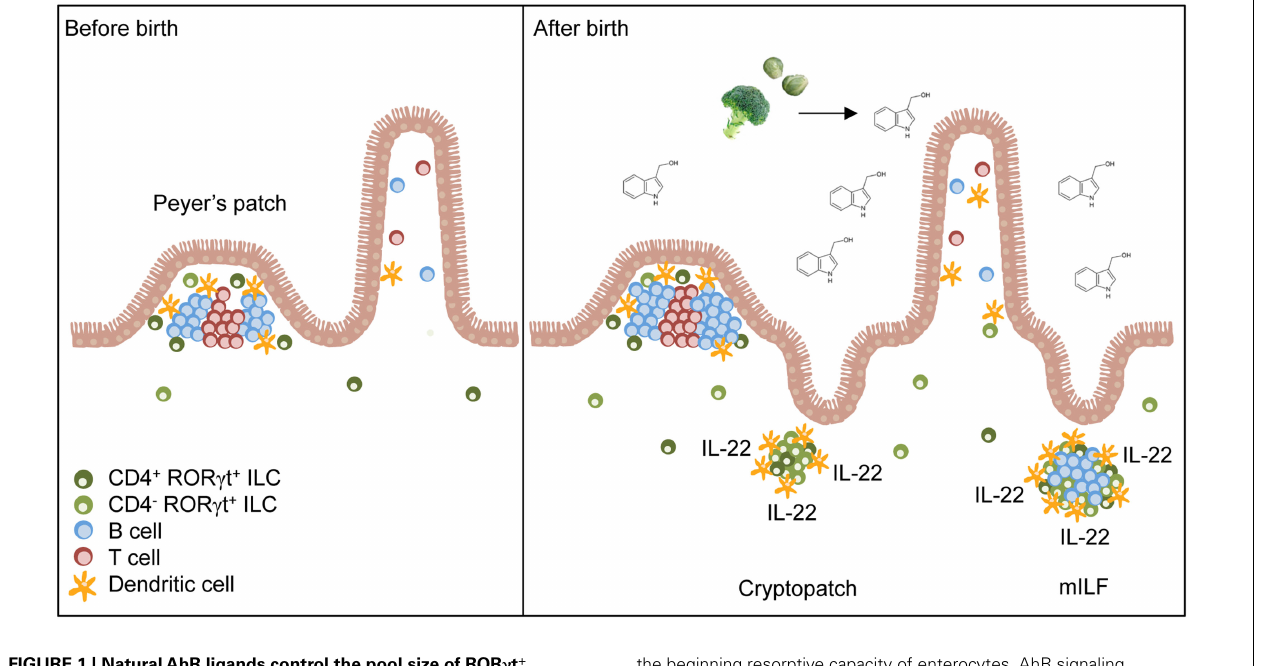
the beginning resorptive capacity of enterocytes. AhR signaling induces the expansion of CD4 − ROR γ t + ILC leading to the formation of cryptopatches and ILF. Furthermore, AhR increases IL-22 production by ROR γ t + ILC and consequently reinforces epithelial protection against